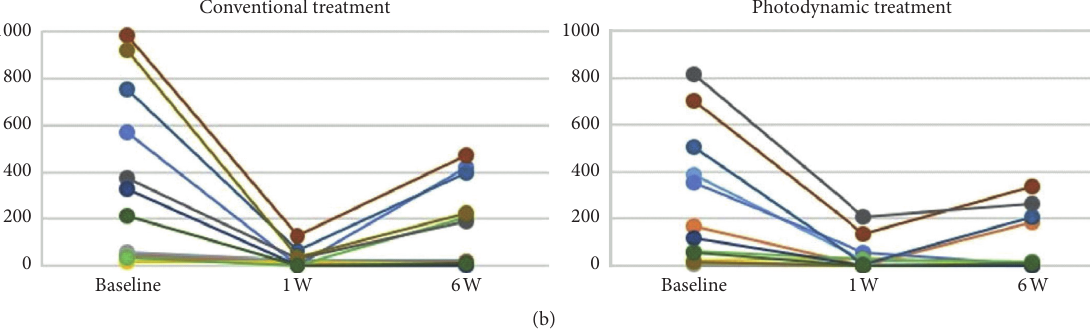
Figure 2: Effect of conventional and photodynamic treatments on the amount of F. nucleatum copy unit (a) and P. intermedia copy unit (b) from each 12 chronic periodontitis patients at baseline, a week, and 6 weeks following nonsurgical periodontal